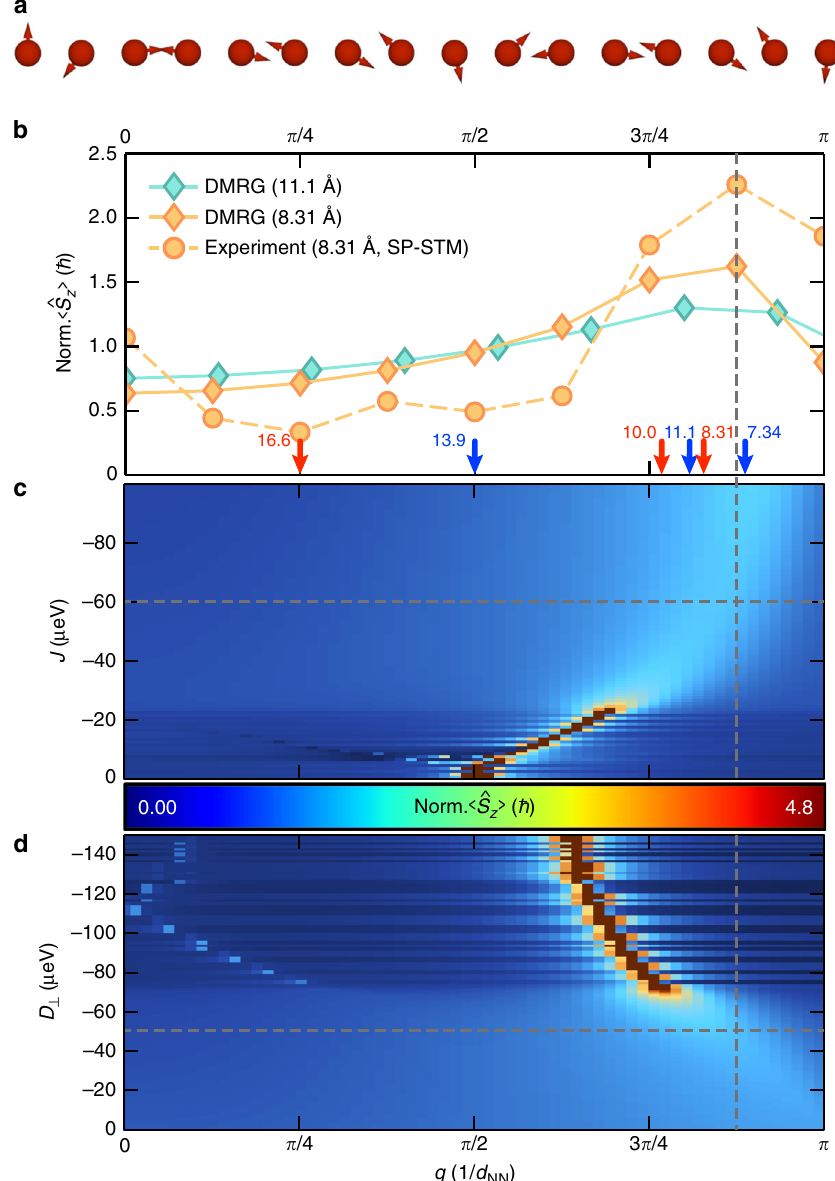
Fig. 5 Determination of the spin-spiral wavevector from experiment and DMRG. a Illustration of the spin-spiral realized in the 3 a -chain using the DMRG calculated vectors ðh ^ S jj ; i i ; h ^ S z ; i iÞ with the length set to unity. b Comparison of the Fourier transform of the experimental spin-asymmetry (orange dots) taken from Fig. 4 with the spin-structure factor h ^ S z ð q Þi obtained from the DMRG calculation of a d NN = 3 a ( N = 16, orange diamonds) and a d NN = 4 a ( N = 16, cyan diamonds) chain using the NN interactions experimentally determined from pairs ( d NN = 3 a : J NN = − 60 μ eV, D ⊥ ,NN = − 50 μ eV; d NN = 4 a : J NN = − 25 μ eV, D ⊥ ,NN = + 30 μ eV; remaining parameters given in Table 1). The curves are normalized to the area. The colored arrows indicate the calculated wavevectors q and rotational sense (blue: positive, red: negative) of spin-spirals in chains ( N = 128) with d NN given in Å by the numbers besides the arrows. They were determined from the maxima of the calculated h ^ S z ð q Þi using the experimental pair-interactions from ref. 25 (slightly adjusted J NN for d NN = 4 a , see Supplementary Fig. 16). c h ^ S z ð q Þi as a function of J with a constant D ⊥ = − 50 μ eV ( N = 128). d h ^ S z ð q Þi as a function of D ⊥ with a constant J = − 60 μ eV ( N = 128). The experimental parameters of the 3 a -chain are indicated by the dashed gray line